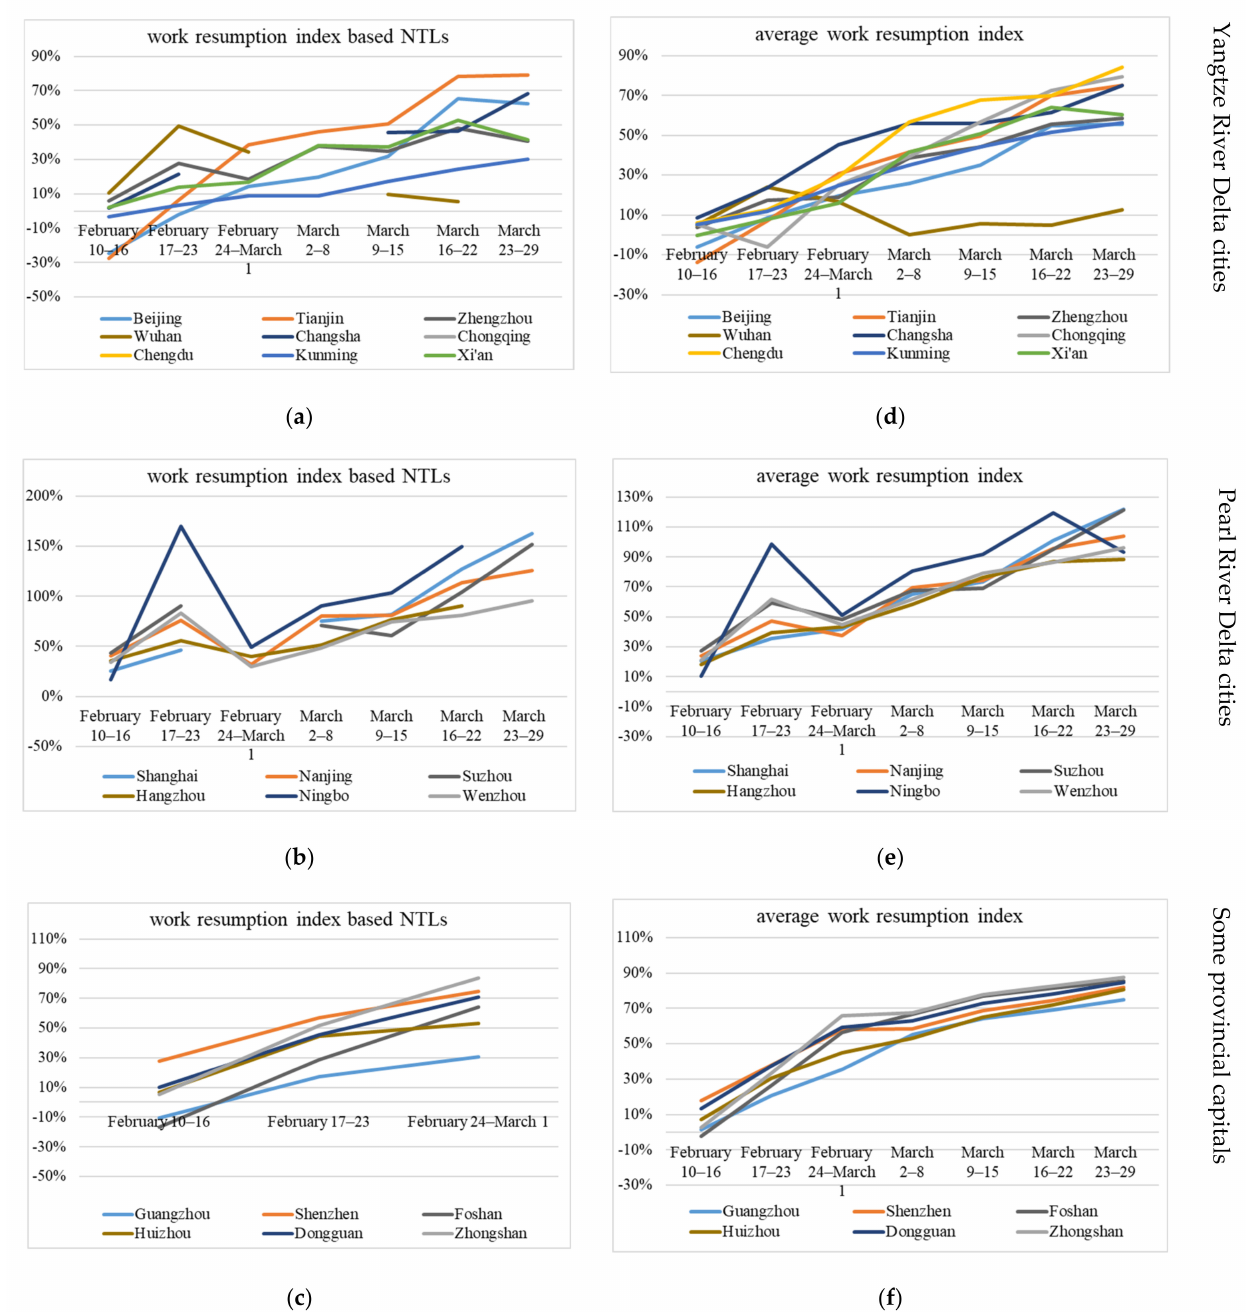
Figure 6. Work resumption indexes in 21 cities. The first lines ( a , d ) are the line chart of some provincial capitals, the second line ( b , e ) are Yangtze River Delta cities, the last line ( c , f ) are Pearl River Delta cities. The first column ( a – c ) are based on night-time light only, the second column ( d – f ) are averaging the work resumption rate based on NTLs and the urban travel